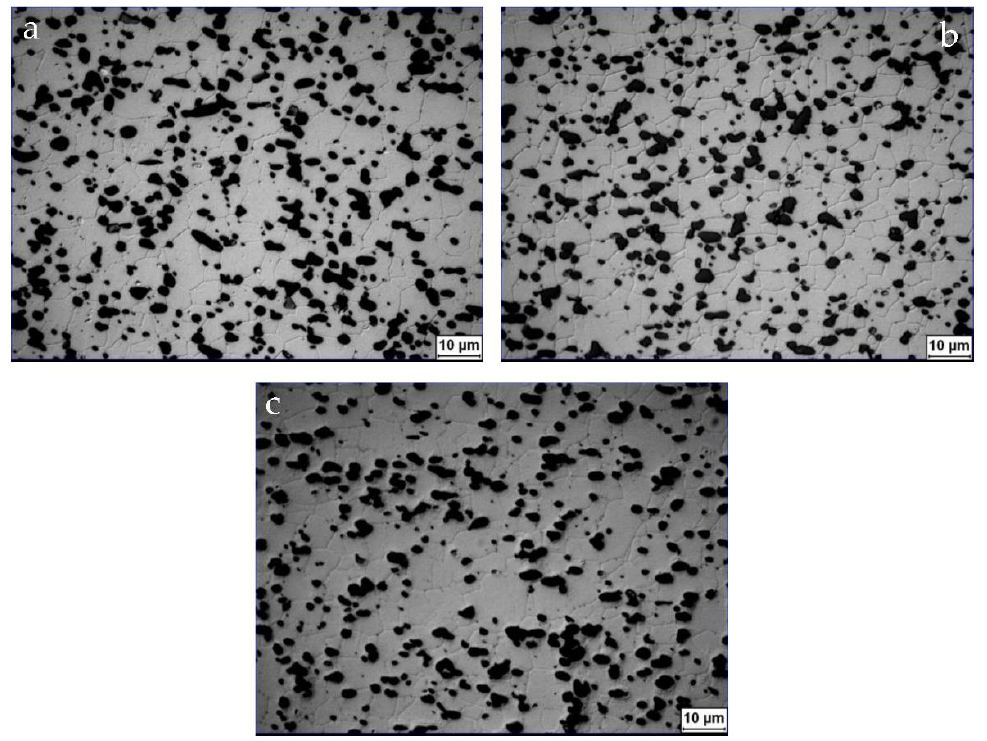
Figure 2. Optical micrographs of as-extruded alloy after heat treatment: ( a ) 520 °C × 30 min + 180 °C